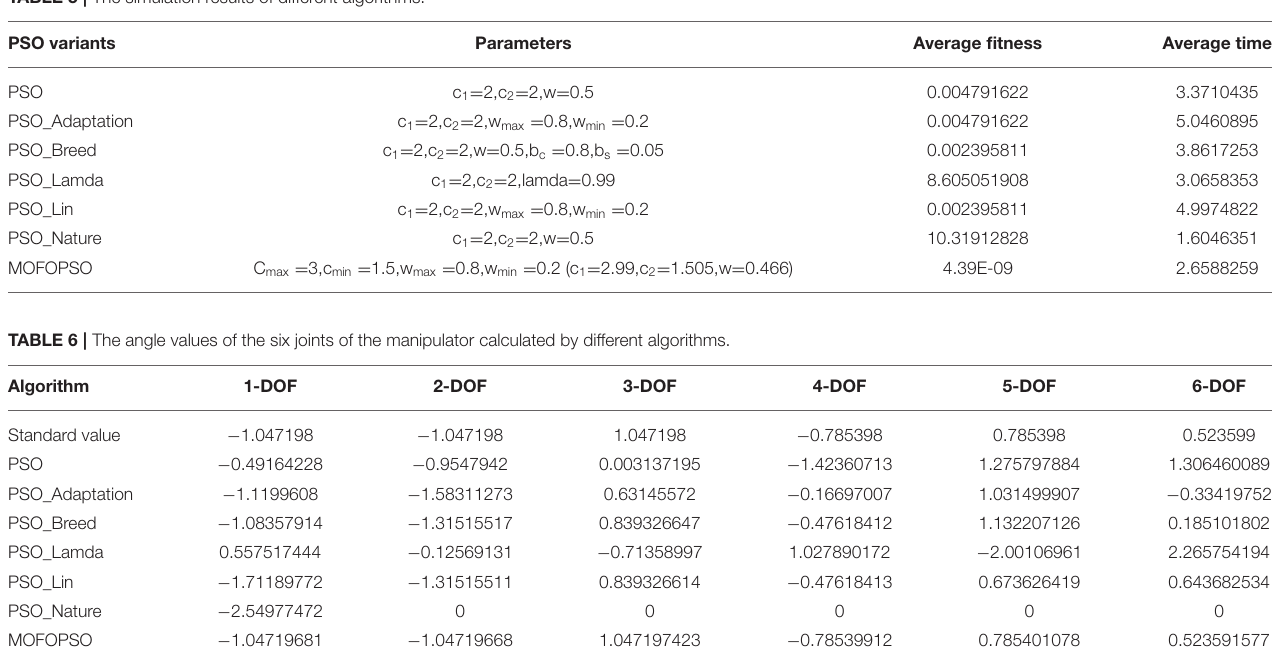
TABLE 5 | The simulation results of different algorithms.